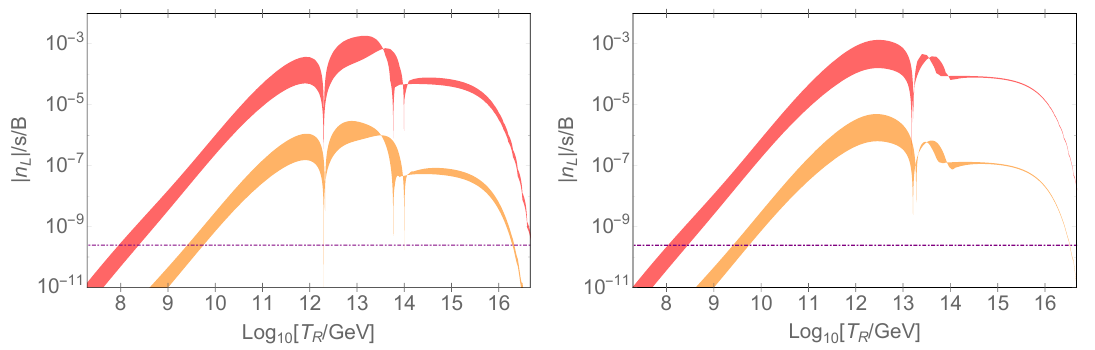
Figure 2 . The dependence of lepton asymmetry on the reheating temperature with degenerate neutrino mass, m (cid:23) lightest = 0 : 07 eV. We take (cid:11) M 2 = 0. The neutrino masses are in normal (inverted) ordering in the left (right) panel. The other parameters are the same as (cid:12)gure 1.